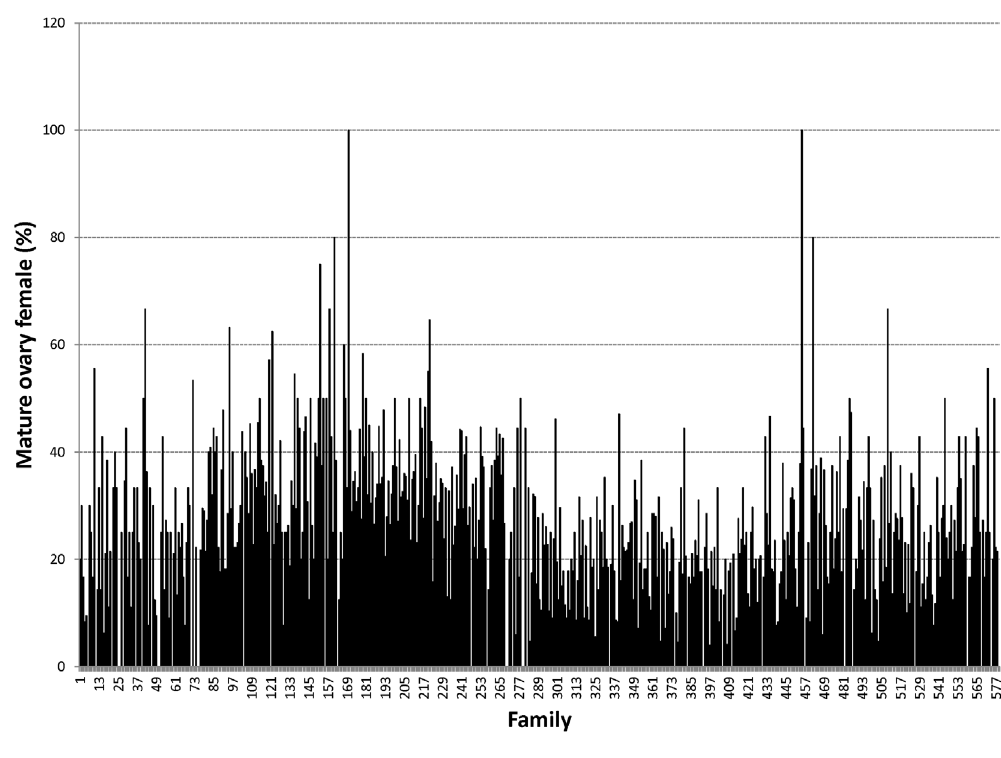
Figure 6. Mature ovary female.